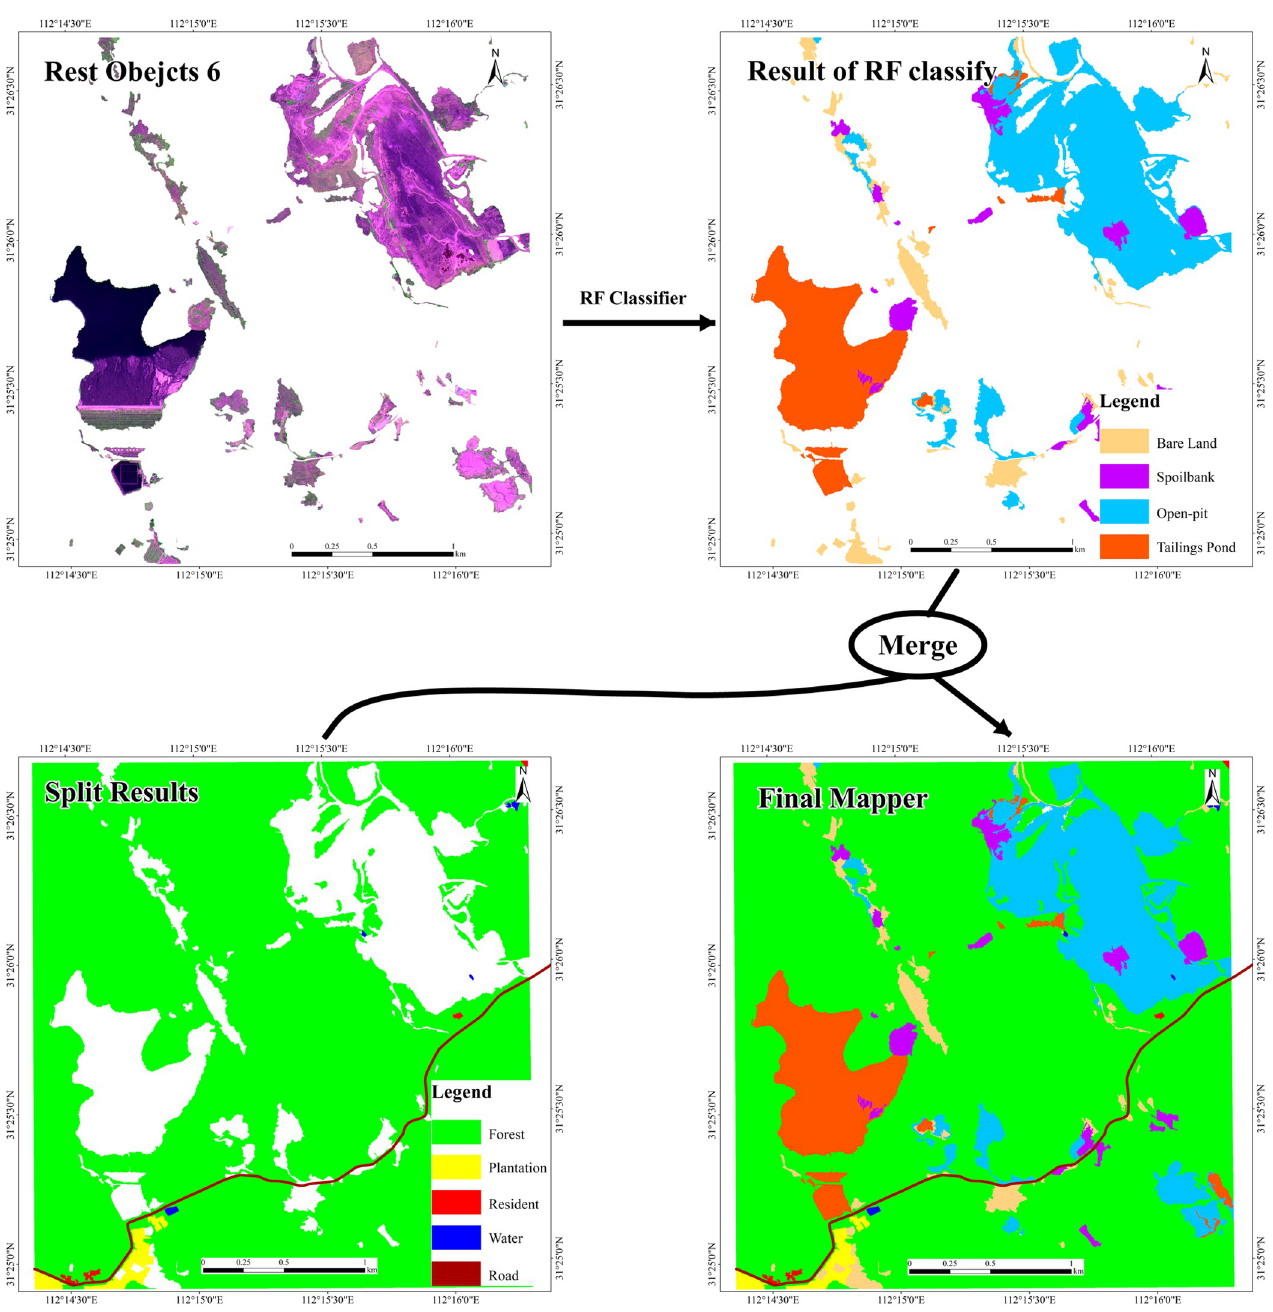
Fig 5. Extraction result of mine development land occupation information based on RF model. Republished under a CC BY license, with permission from HBUT, original copyright 2017.